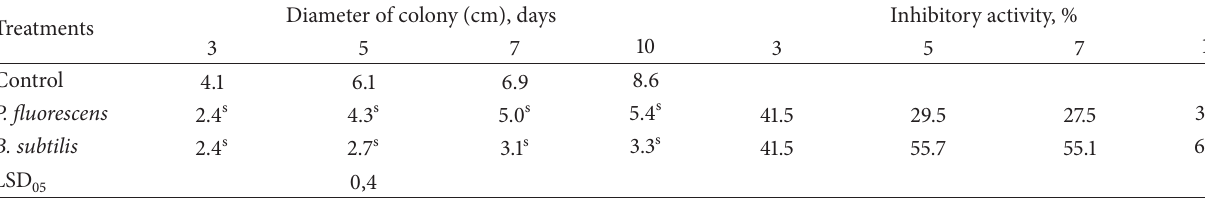
Table 2: The effect of the biocontrol agents on D. applanata growth in vitro . Treatments